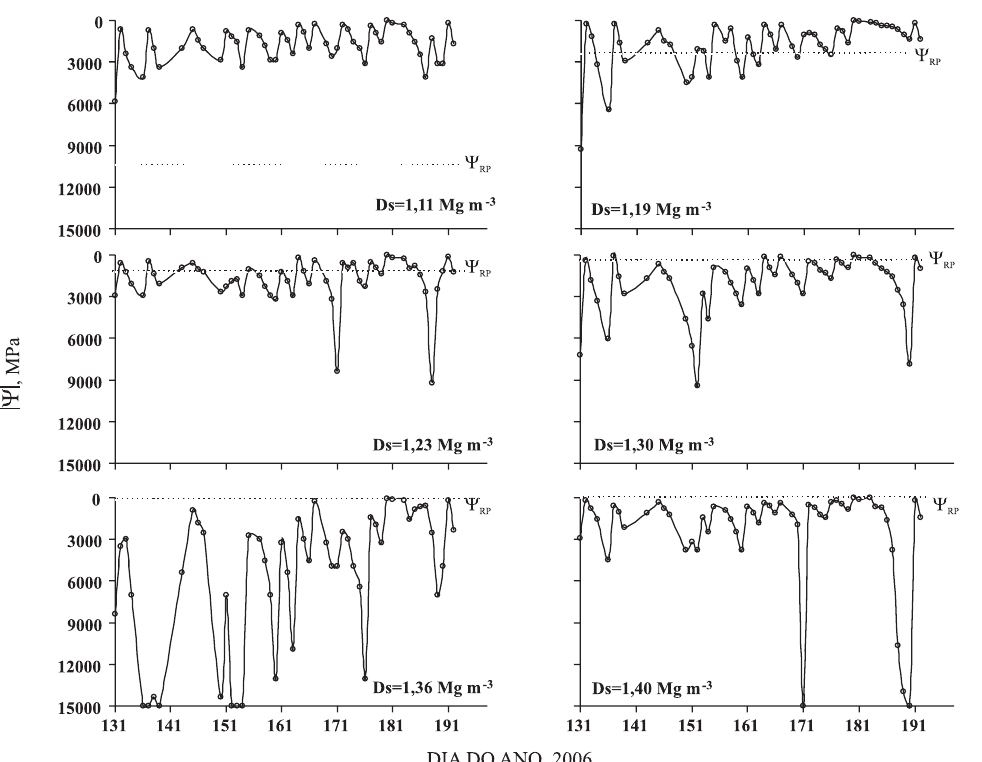
Figura 3. Variação temporal do potencial da água no solo (valores de ΨΨΨΨΨ em módulo) em relação ao limite crítico de resistência do solo à penetração ( ΨΨΨΨΨ ) para o período de RP